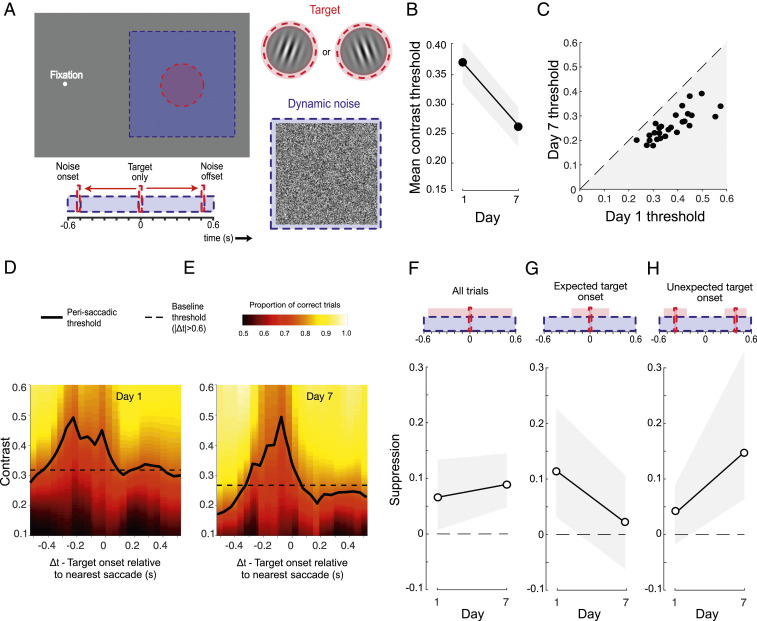
Suppression reduction is tuned to the expected time window. (A) The Temporal transfer task differed from the main task in only one respect: The target appeared at a random time within a 1 s interval centred on the expected target onset. (B) Mean thresholds were lower after training, indicating some transfer of learning. (C) All subjects (represented as dots) had lower thresholds on day 7 than on day 1. (D and E) Saccadic suppression was of a similar magnitude on day 7 as it was on day 1. (F) In the window −100 ms < Δt < 100 ms, suppression marginally increased on day 7 relative to day 1. (G) Considering only those trials in which the target occurred near to the expected time, suppression reduction was apparent on day 7 relative to day 1. (H) Conversely, suppression increased on day 7 relative to day 1, if only those trials in which the target deviated from the trained onset time are considered. All error bars show 95% CIs.